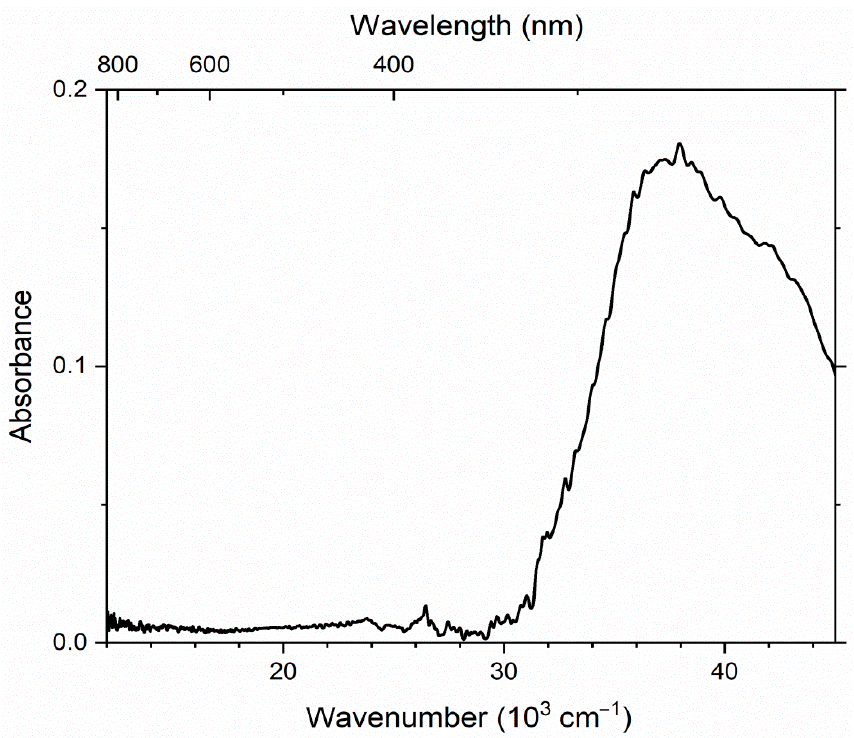
Figure 10. Diffuse absorption spectrum of nosean (Sample 7) measured at room temperature.